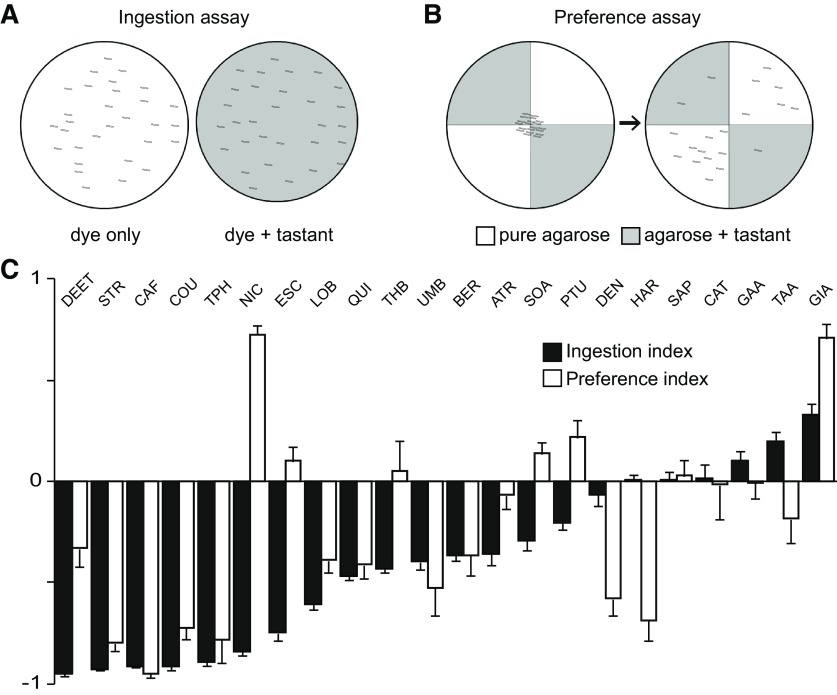
 Responses toward putative bitter tastants in larval ingestion and choice assays. A, Schematic drawing of the ingestion assay. Two agarose gel plates were used, with one containing only 1% indigo carmine dye (left, white) and one also containing a bitter substance (right, shaded). Thirty larvae were placed on each plate and allowed to forage and feed freely for 90 min. The ratio of dye ingested by the two groups was measured to calculate the I.I.. B, For the choice preference assay, larvae were placed onto a quadrant plate made with two types of agarose gel: agarose only (white quadrants) and tastant included (shaded quadrants). After 8 min, the number of larvae on each quadrant was counted to analyze the larval behavioral response to the compound. The short lines in A, B indicate larvae. C, Comparison of ingestion and choice preference behavioral responses for the twenty-two bitter compounds tested. Compounds are arranged in order of increasing I.I. values from left to right. Each data point was derived from 6 < n. Error bars are SEM. The following concentrations were used: 10 mM ATR, 5 mM BER, 100 mM CAF, 10 mM CAT, 10 mM COU, 1% DEET, 10 mM DEN, 1 mM ESC, 50 mM GAA, 10 mM GIA, 5 mM HAR, 10 mM LOB, 10 mM NIC, 1 mM PTU, 10 mM QUI, 0.1% SAP, 1 mM SOA, 100 mM STR, 1 mM TAA, 30 mM THB, 100 mM TPH, and 10 mM UMB (Extended Data Figure 1-1).